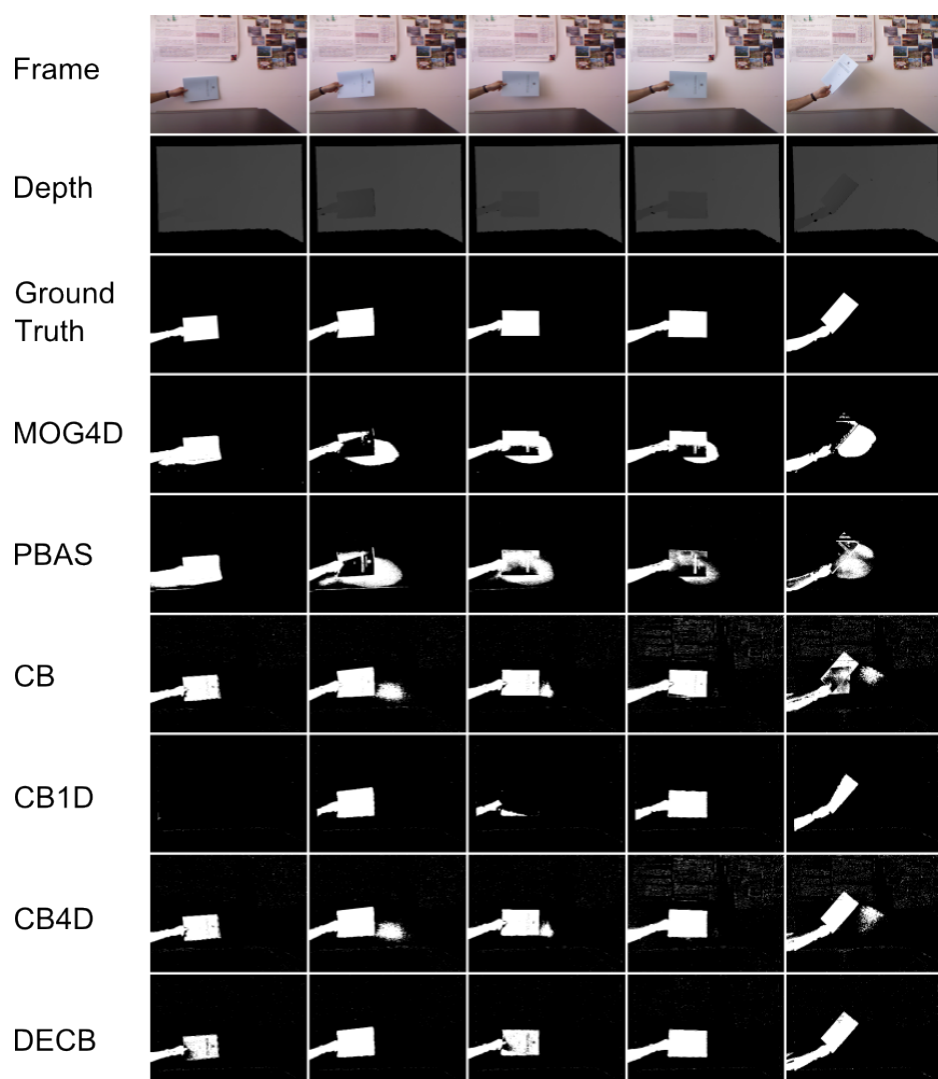
Figure 5. Results obtained from the test,